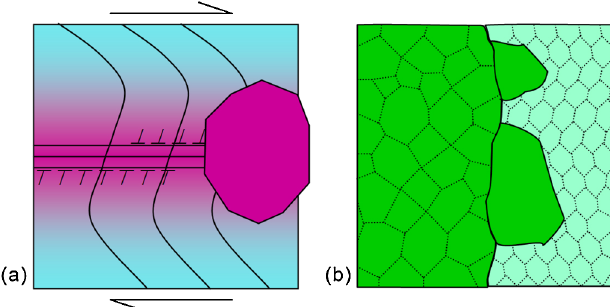
14. (Color) Schematic diagram of two forms of recrystal- lization: (a) subgrains within locally rotated shear bands nucleate to grow into surrounding lesser deformed material; (b) grain with larger subgrains (left) grows into grain with smaller subgrains